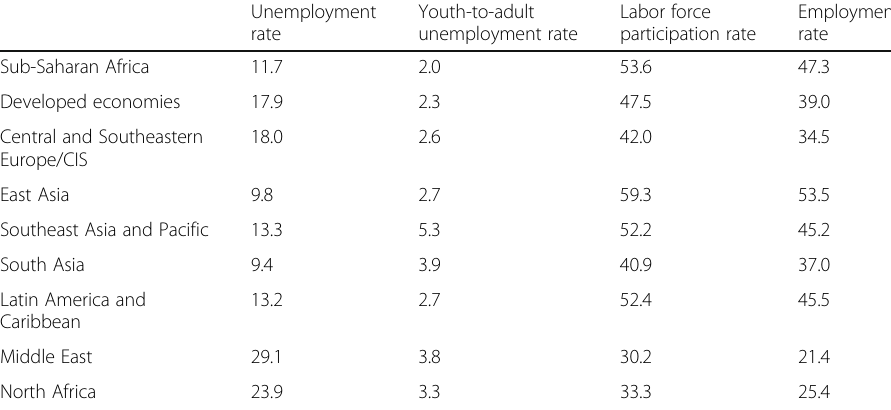
Labor force Employment participation rate rate